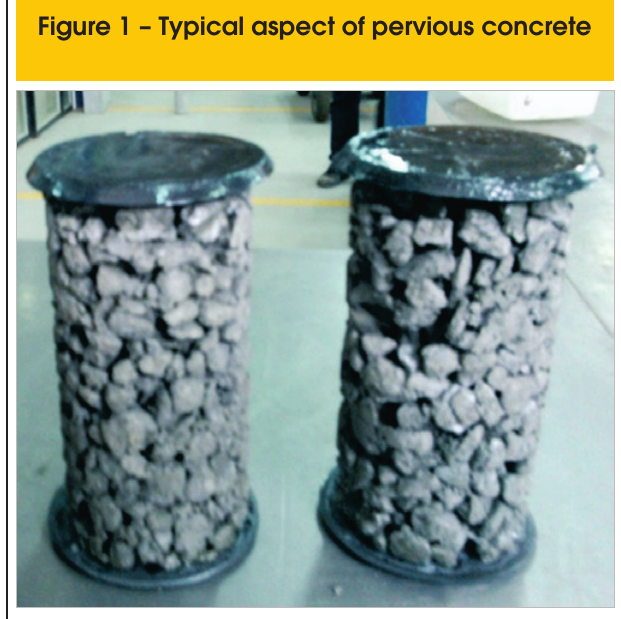
Figure 1 – Typical aspect of pervious